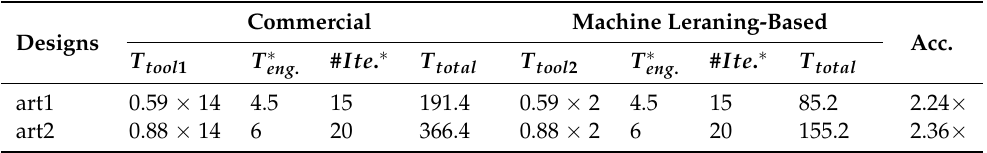
Table 6. Runtime of commercial and machine-learning-based method in Industrial Application